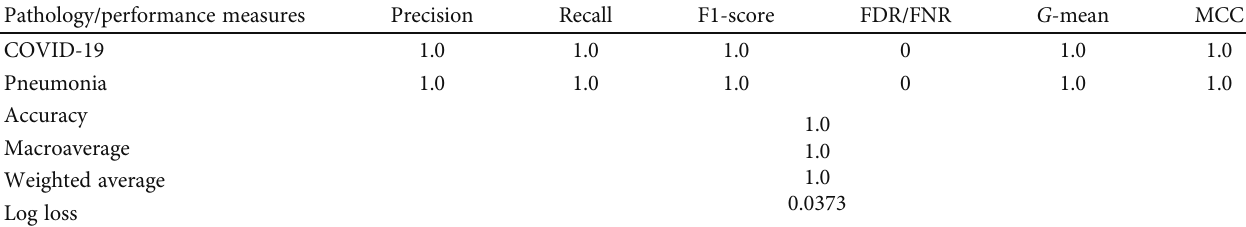
Table 3: The performance of the system model with VGG16.